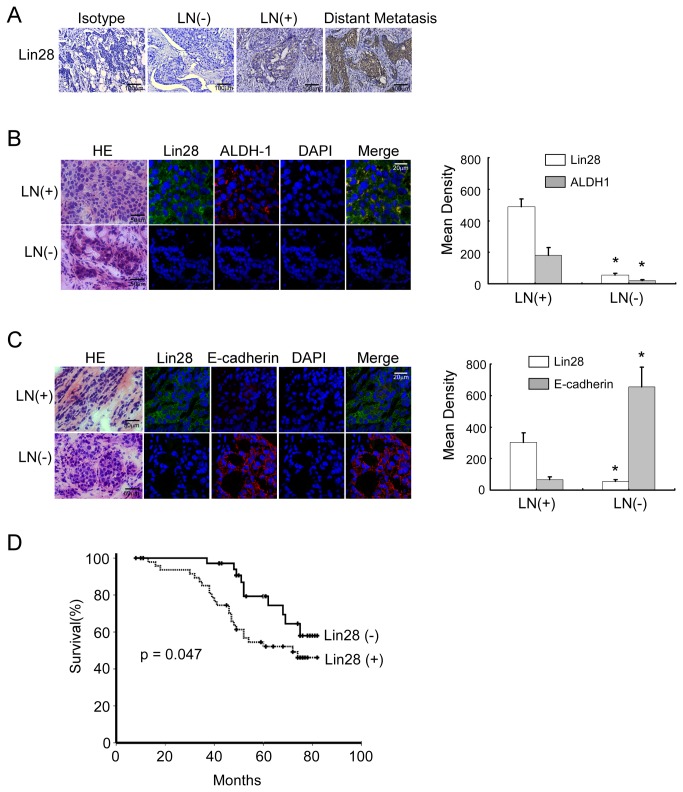
Lin28 expression in breast cancer is correlated with tumor invasiveness.A. Lin28 immunohistochemical staining was performed in samples obtained from breast cancer patients with or without axillary lymph node metastases or with distant metastases. An isotype-matched antibody was used as a negative control. B and C. (Left) Confocal microscopy for double immunostaining of Lin28 (green) and cytoplasmic expression of ALDH1 (red) (B) and membrane expression of E-cadherin (red) (C) in breast cancer tissue samples that had been obtained from patients with (upper) or without (lower) lymph node metastases. H&E staining was performed on frozen sections of the same breast cancer tissues. Cell nuclei (blue) were counterstained with DAPI. (Right) Statistical mean of the fluorescence density of Lin28, ALDH1 and E-cadherin in LN (+) and LN (-) breast cancer sections. D. A Kaplan-Meier survival curve was established for patients who had breast cancers with low and high Lin28 expression, with a median follow-up period of 57 months, p < 0.05.